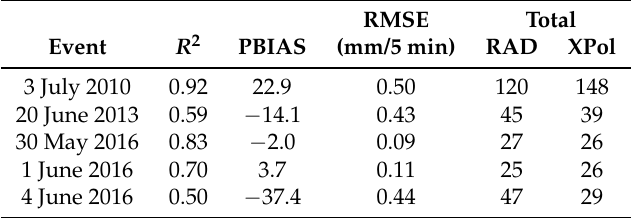
Figure 3. Comparison of cumulative RADOLAN and XPol QPE rain depth , where P is the precipitation in mm. Table 3. Comparison of XPol and RADOLAN radar